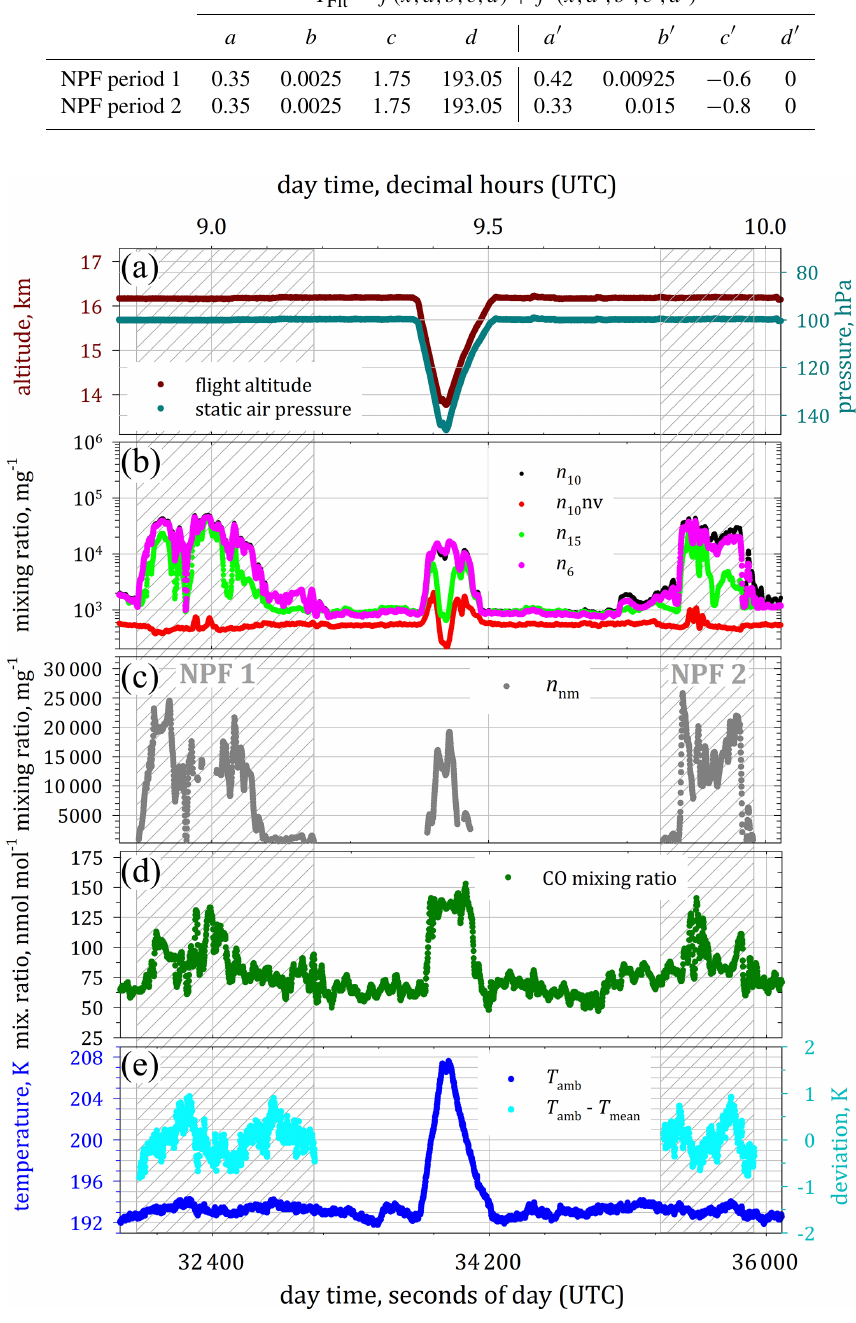
Figure 13. Time series of data sampled during a section of a StratoClim 2017 flight (KTM 6) on 6 August 2017. Except the manoeuvre period between 09:20 and 09:30 (UTC), a constant altitude and pressure level (a) were maintained. Particle mixing ratios ( n 6 , n 10 , n 15 , and n 10 nv) (b) , the mixing ratio of the nucleation-mode particles ( n nm ) (c) , the CO mixing ratio (d) , and the ambient air temperature ( T amb ) and the temperature fluctuation ( T amb − T mean ) (e) feature different characteristics and sequence during two NPF phases (oblique hatched